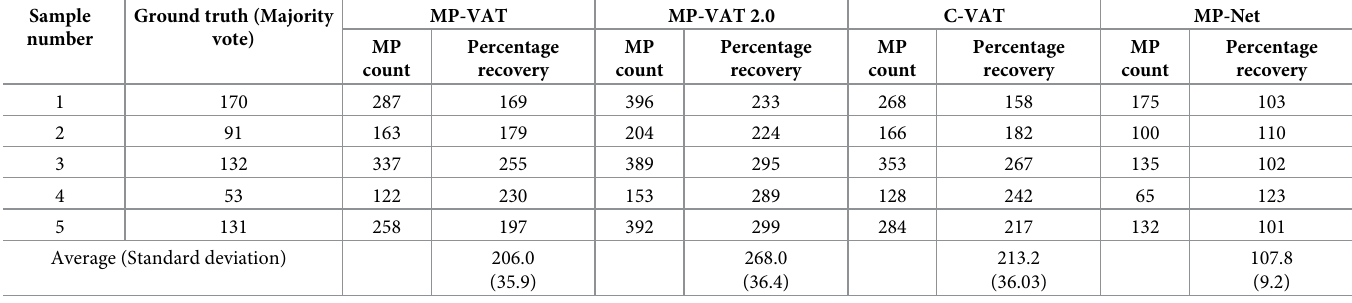
Table 5. MP count and percentage recovery obtained for five spiked MP images. The MP quantity predicted by MP-Net was much closer to the ground truth compared to MP-VAT, MP-VAT 2.0, and C-VAT. Sample Ground truth (Majority number vote)